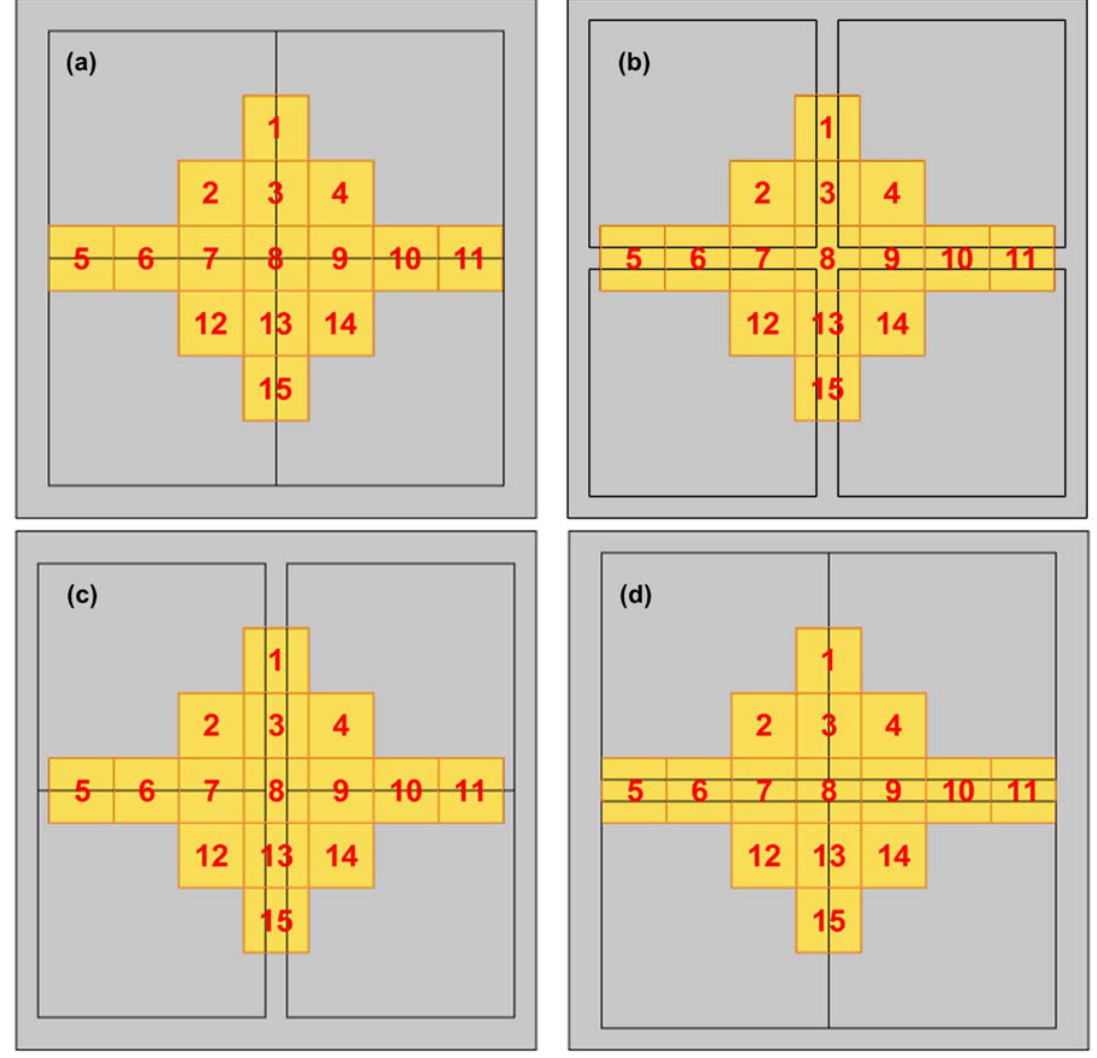
Figure 3. Location of HFTs (heat flux transducers) with respect to the VIPs in the small ‐ scale composites. The samples ‘a’–‘d’ correspond to the small ‐ scale composites with different VIP configurations. ( a ) all VIPs butt ‐ jointed; ( b ) foam gaps between all VIPs; ( c ) VIPs butt ‐ jointed along the length and with a foam gap along the width; ( d ) VIPs butt ‐ jointed along the width and with a foam gap along the length.